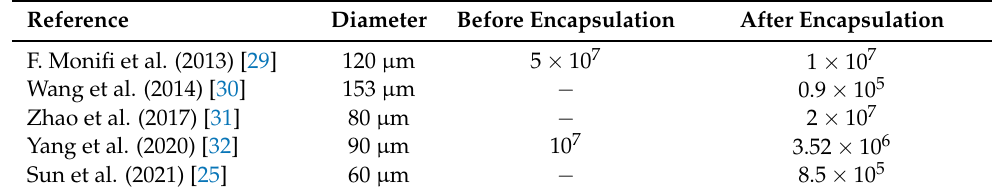
Figure 2. Transmission spectrum of the microsphere cavity. ( a ) Mode i with a central wavelength of 778.0567 nm. ( b ) Mode ii with a central wavelength of 777.6010 nm. The blue solid line represents the experiment data, and the red solid line represents the corresponding Lorenz fitting. Table 1. Variation found in the literature on the quality factor of whispering gallery mode microcavi- ties before and after